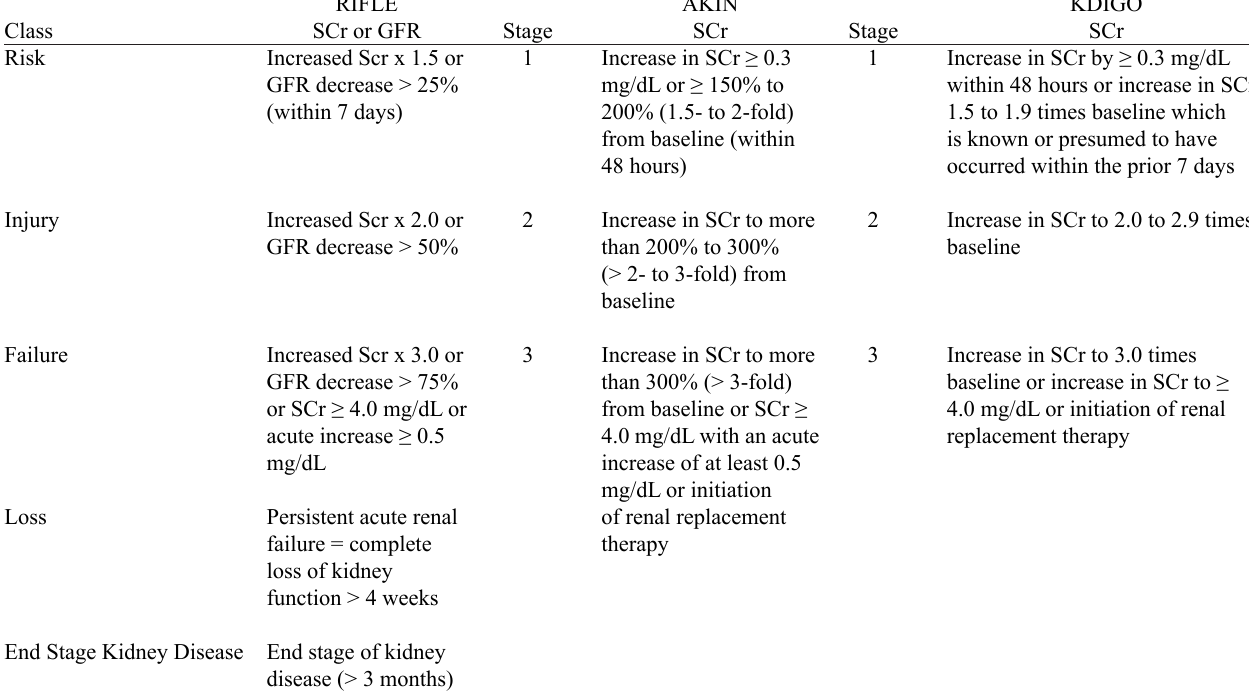
Table 1. Classification and staging for RIFLE, AKIN, and KDIGO